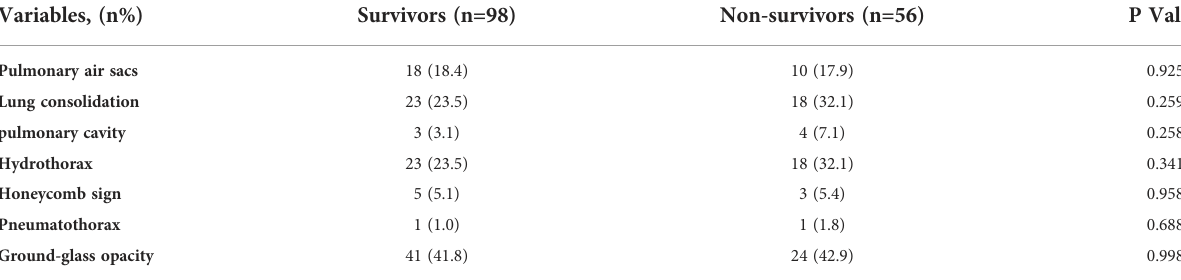
TABLE 3 Comparison of CT fi lms of the two groups of patients. Variables,